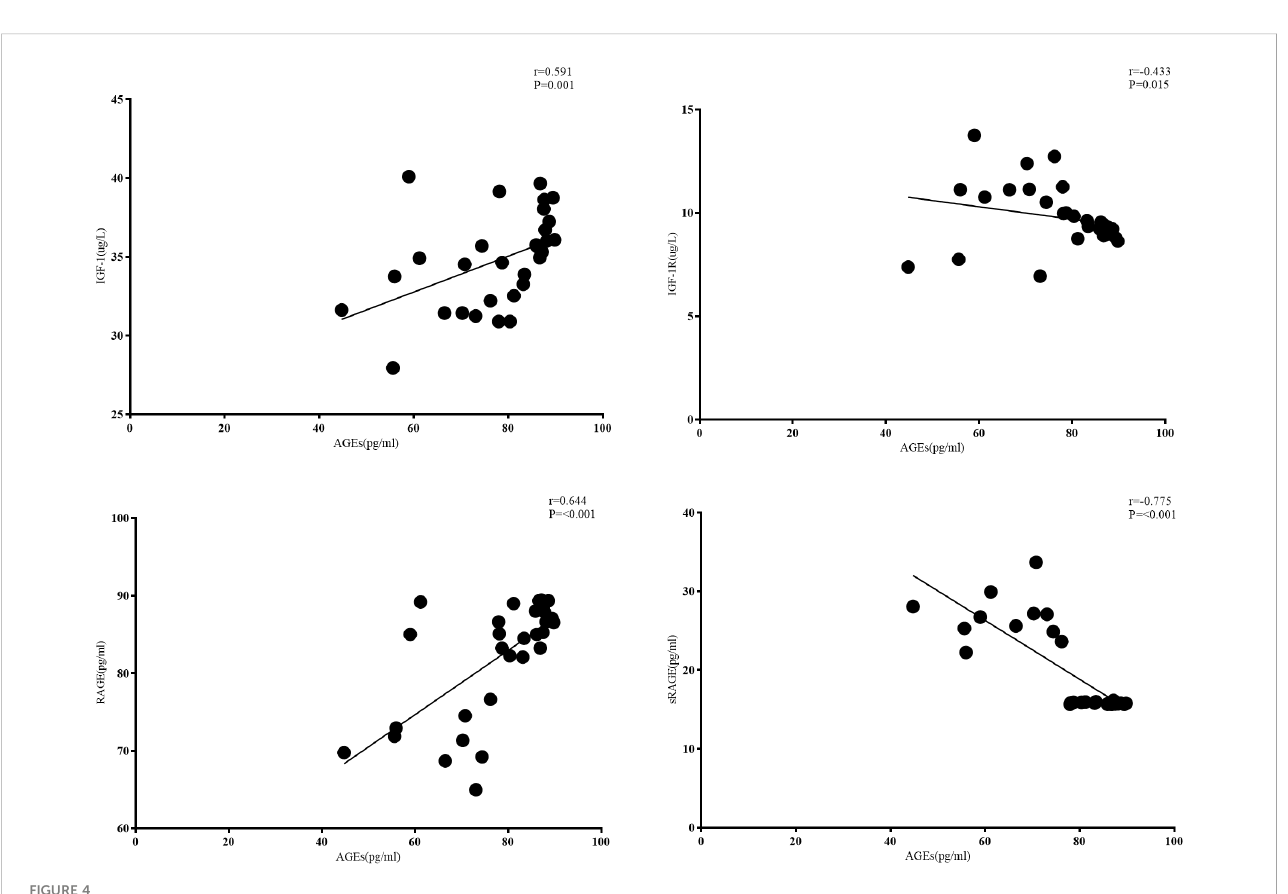
FIGURE 4 Correlation analysis between serum